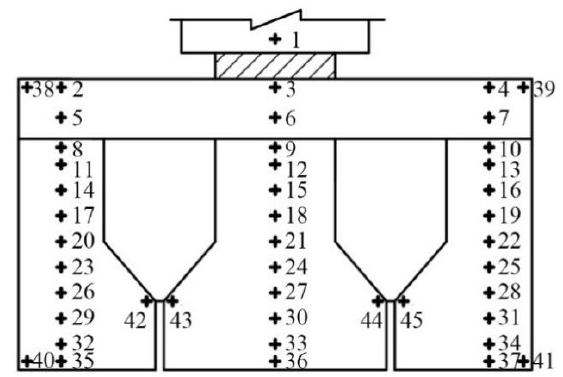
Figure 4. Layouts of instruments: ( a ) DIC instruments; ( b ) dial gauges.